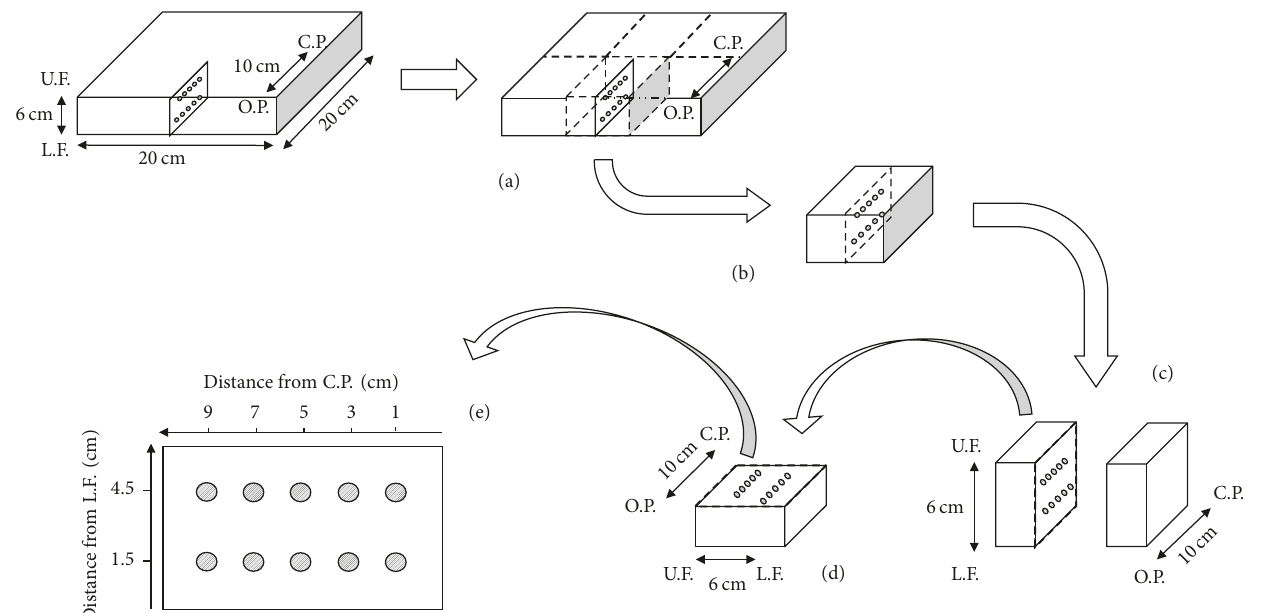
Figure1:Samplepreparationprocedurefortextureanalysismeasurements.(a)Crescenzacheesemoldswereportionedintosixpartsclassified in function of the sampling zone of the cheese. (b) The central part of the mold was used for textural measurement and was cut into two slices. (c, d) The two slices were positioned with the cutting surface on the top. (e) Top view of the surface subjected to compression test, with references to cheese geometry (LF: lower face of the cheese; UF: upper face of the cheese; CP: central part of the cheese; OP: outer part of the